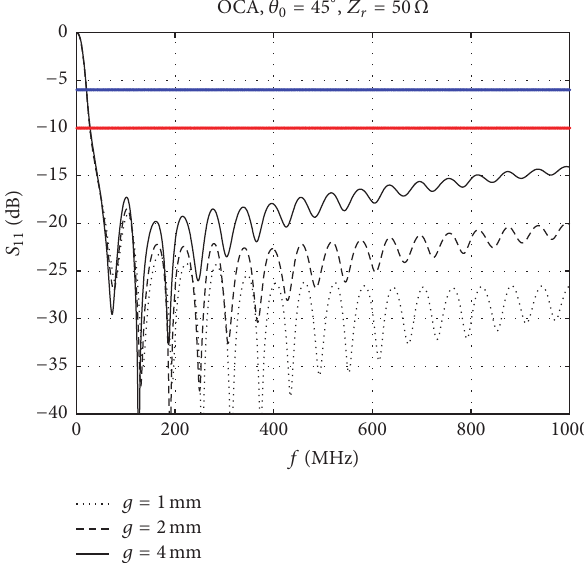
Figure 23: 𝑍 of the OCA for 3 different gap lengths and 𝜃 0 = 75 ∘ in ( 𝑅 : curves above, 𝑋 : curves below). in in